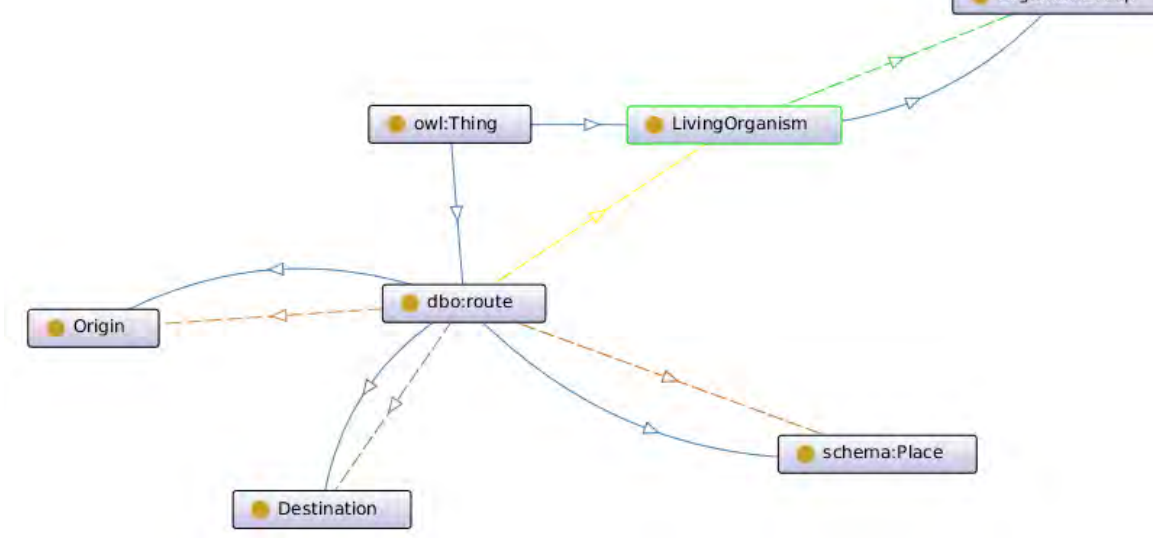
Figure 2 ontological model created on